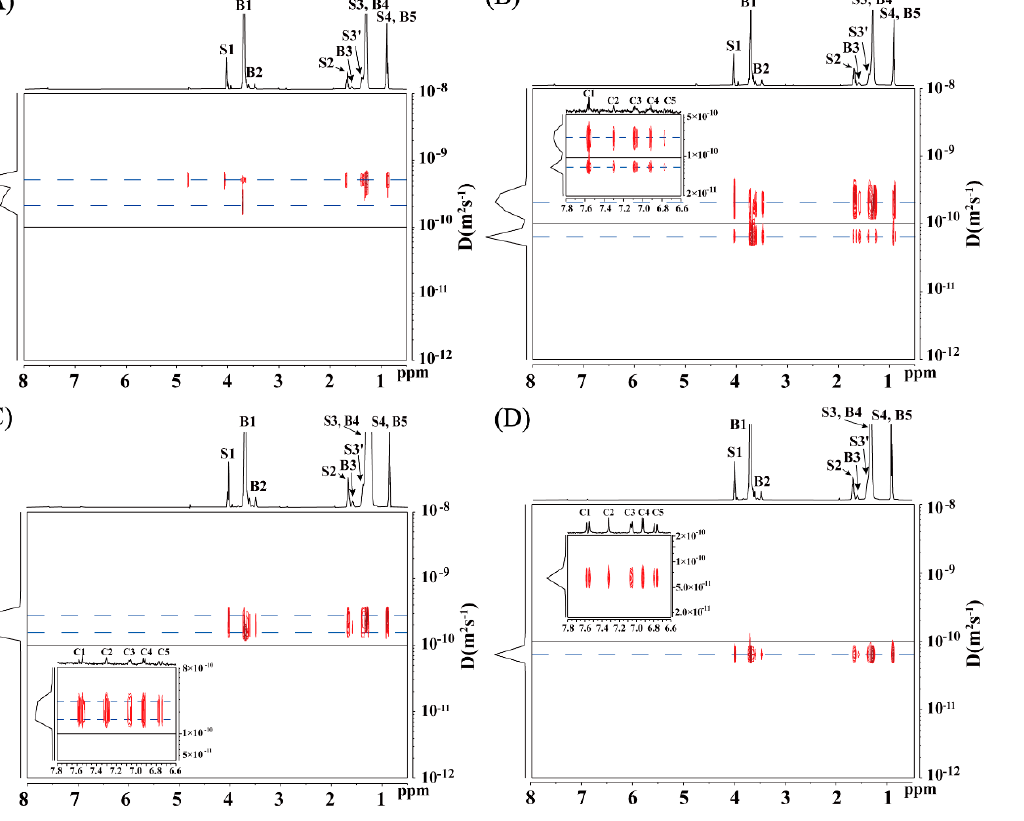
Figure 4. The 2D DOSY plots for the system with α SDS = 0.8 at C T of 0.25 ( A ), 5.0 ( B ), 10 ( C ) and 80 mM ( D ). The black horizontal line at the D value of 10 − 10 m 2 s − 1 is a reference to mark the variation of the diffusion coefficients.